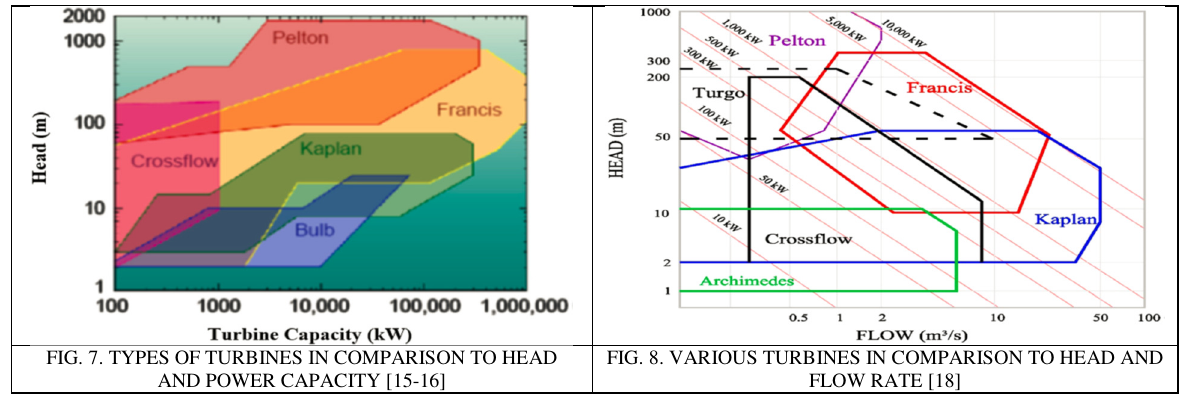
FIG. 7. TYPES OF TURBINES IN COMPARISON TO HEAD AND POWER CAPACITY [15-16]